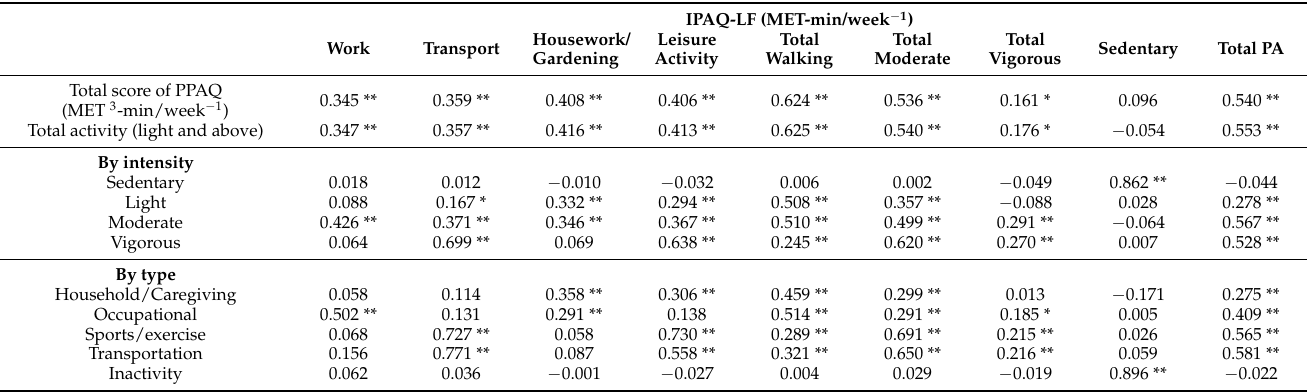
Table 5. Concurrent validity assessed by correlating oPPAQ-SRB 1 scores with IPAQ-LF 2 scores using Spearman’s correlation